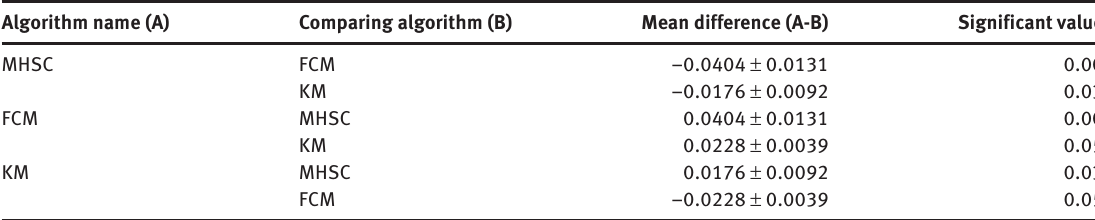
Table 7: Estimated Means and Pairwise Comparisons of Different Algorithms on the Minkowski Score Obtained by ANOVA Testing for the Wine Dataset.